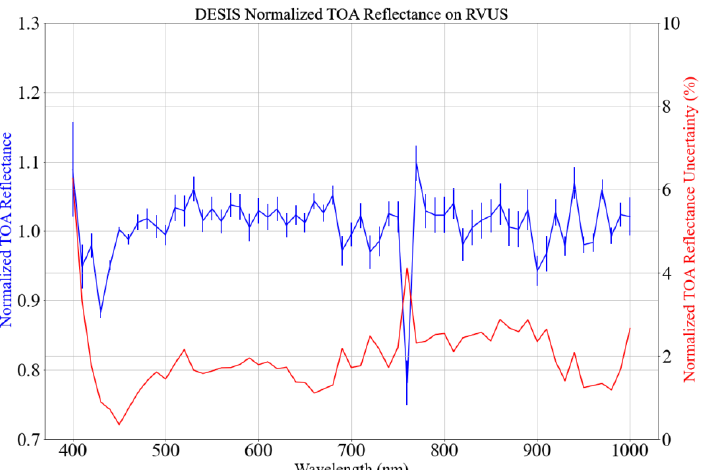
Figure 8. Mean and standard deviation of 4 normalized DESIS TOA reflectance datasets shown in Figure 7a.